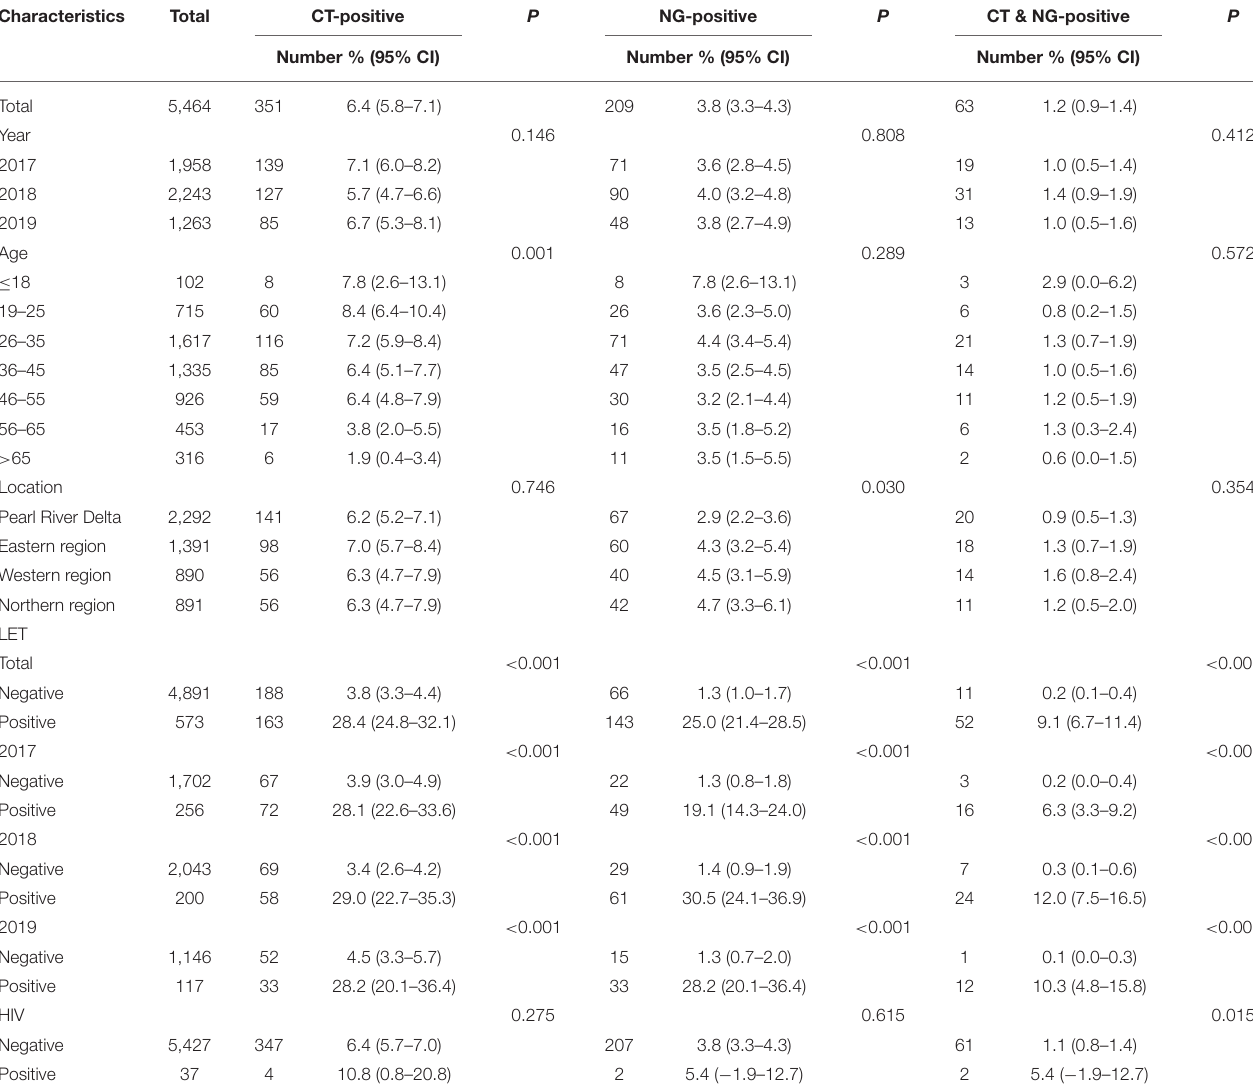
TABLE 1 | Characteristics of the study population and prevalence of Chlamydia and Gonorrhoeae infections in Guangdong, China, 2017–2019 ( N = 5,464).